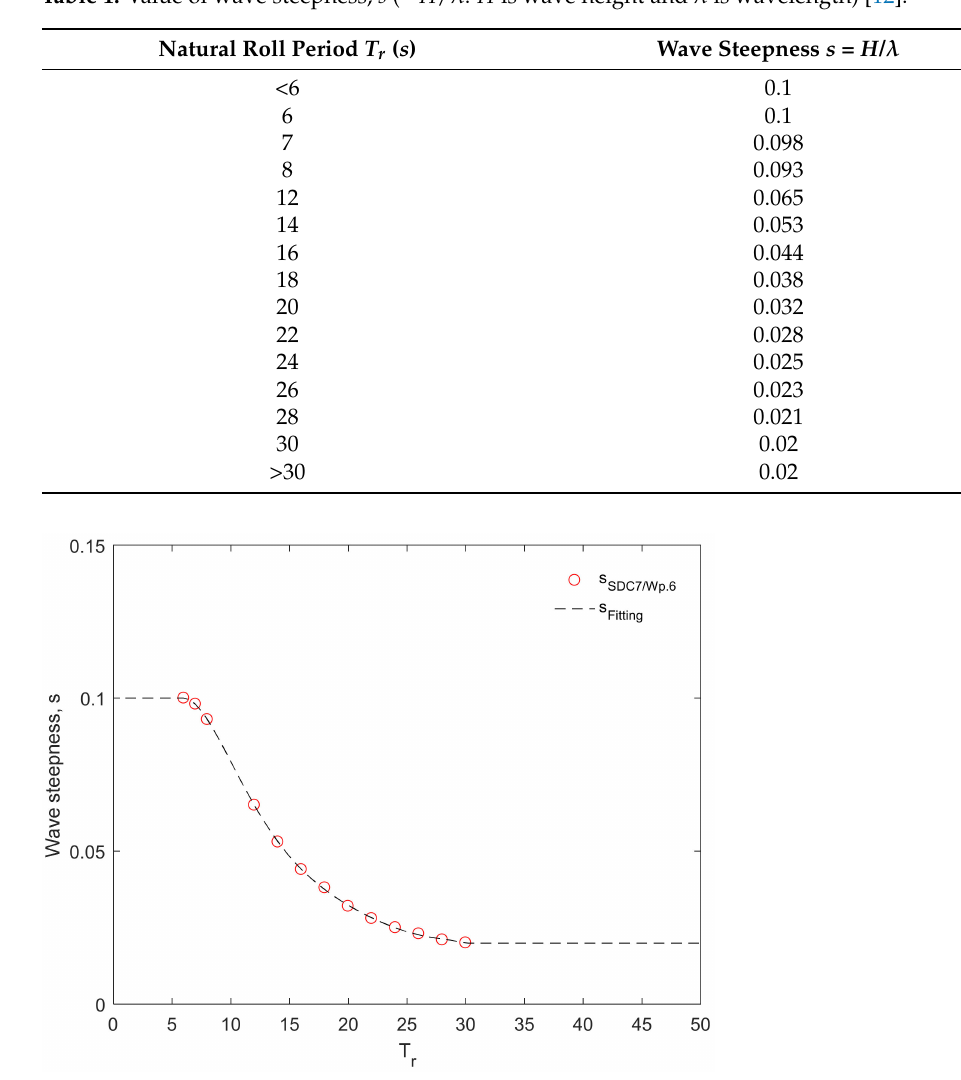
Table 1. Value of wave steepness, s (= H / λ : H is wave height and λ is wavelength) [12].